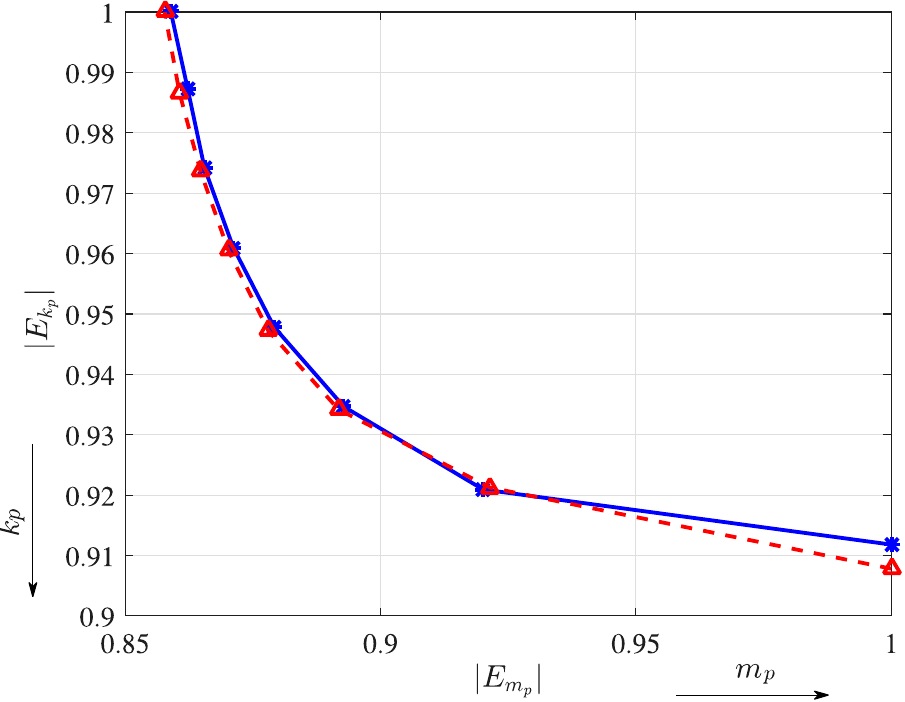
Figure 12. Energy calculated by changing the payload weight and stiffness coefficient for take-off (solid blue line) and cruise (dashed red line) phases.